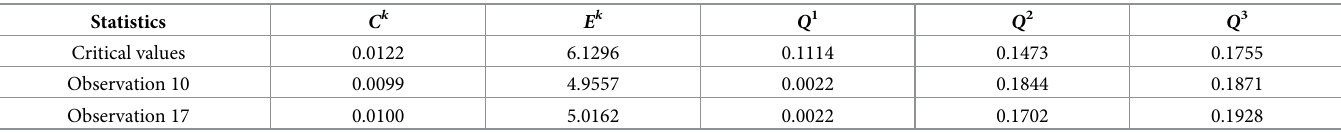
Table 6. The test statistics values and the (10% upper level) critical values of discordancy tests for n = 23 and κ =